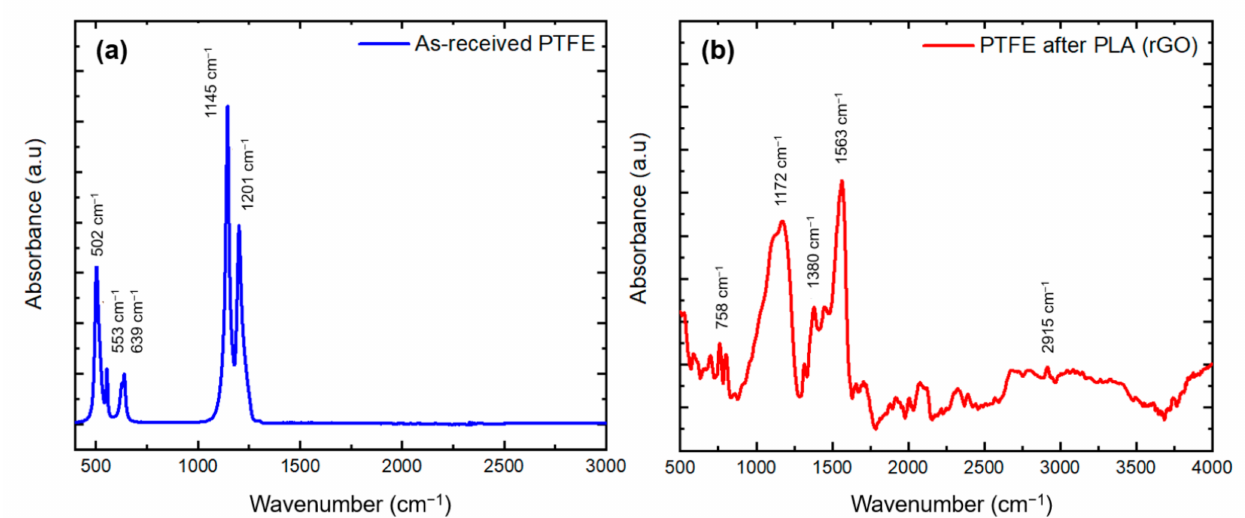
Figure 5. FTIR spectra of ( a ) as-received PTFE and ( b ) PTFE after the laser-annealing